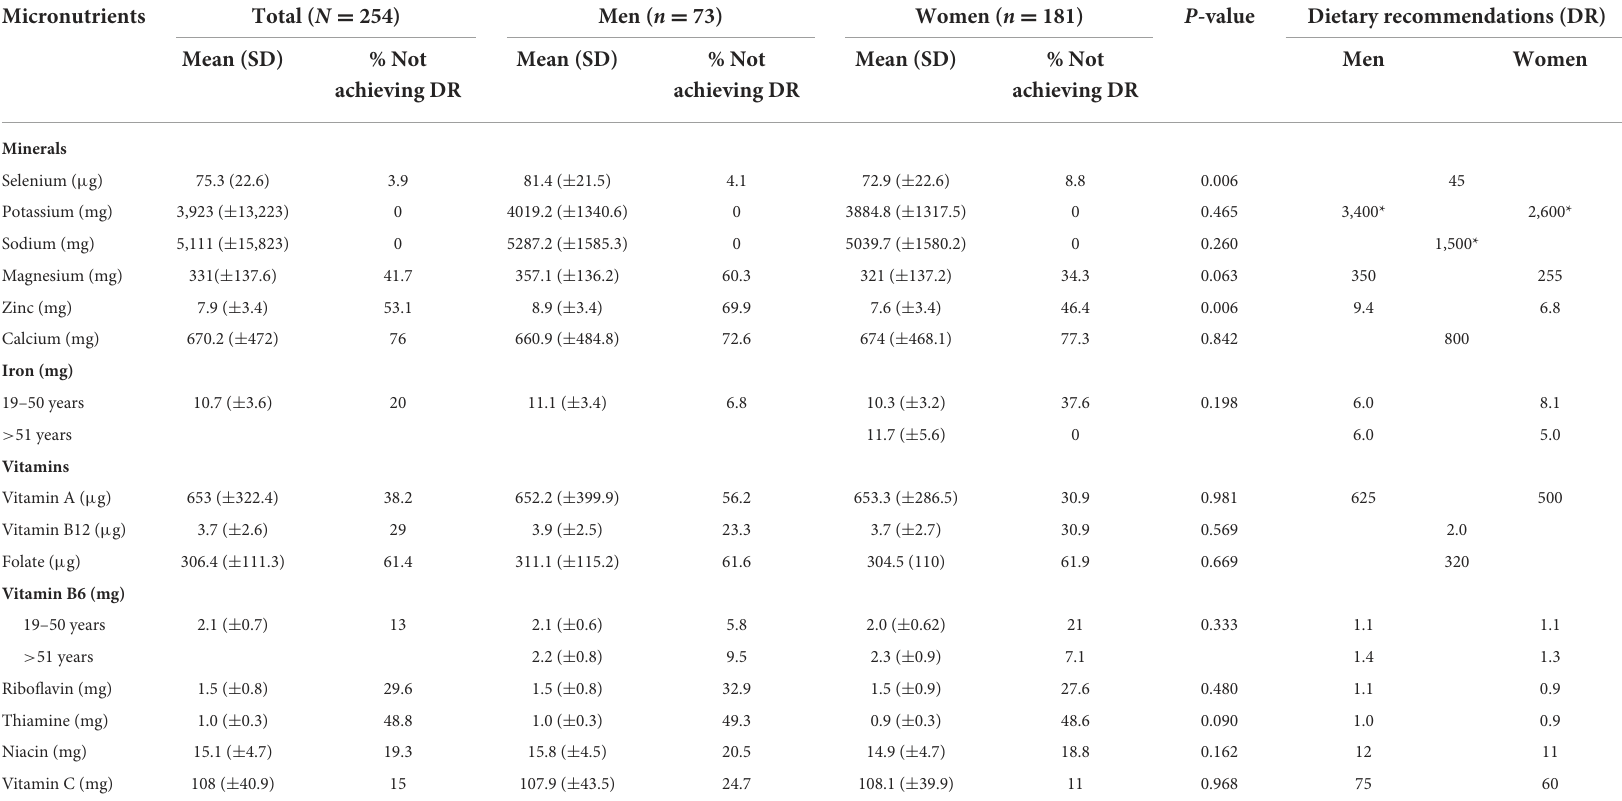
TABLE 5 Usual micronutrient intake by sex and compared with IOM recommendations.